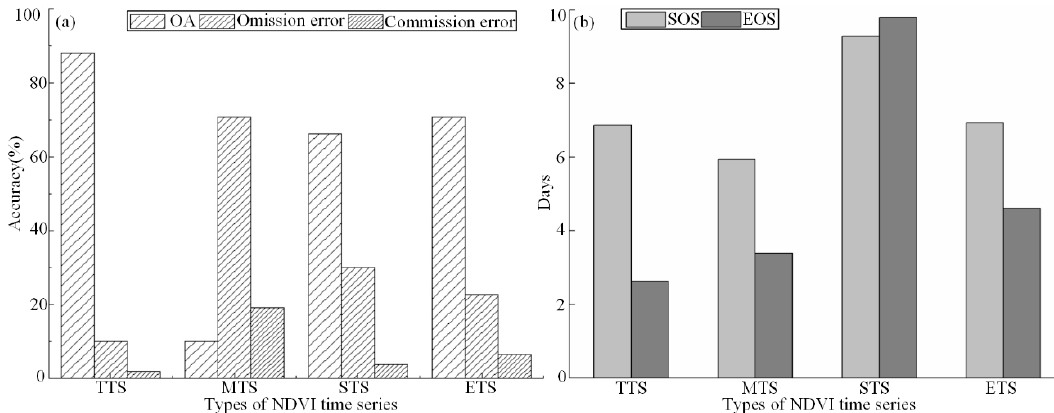
Figure 8. Landsat NDVI performance in land cover change detection and phenological stability analysis, where SOS and EOS represent the start of the growing season and the end of the growing season, and overall accuracy. ( a , b ) represent the statistics of land cover change detection and phenological stability, respectively.